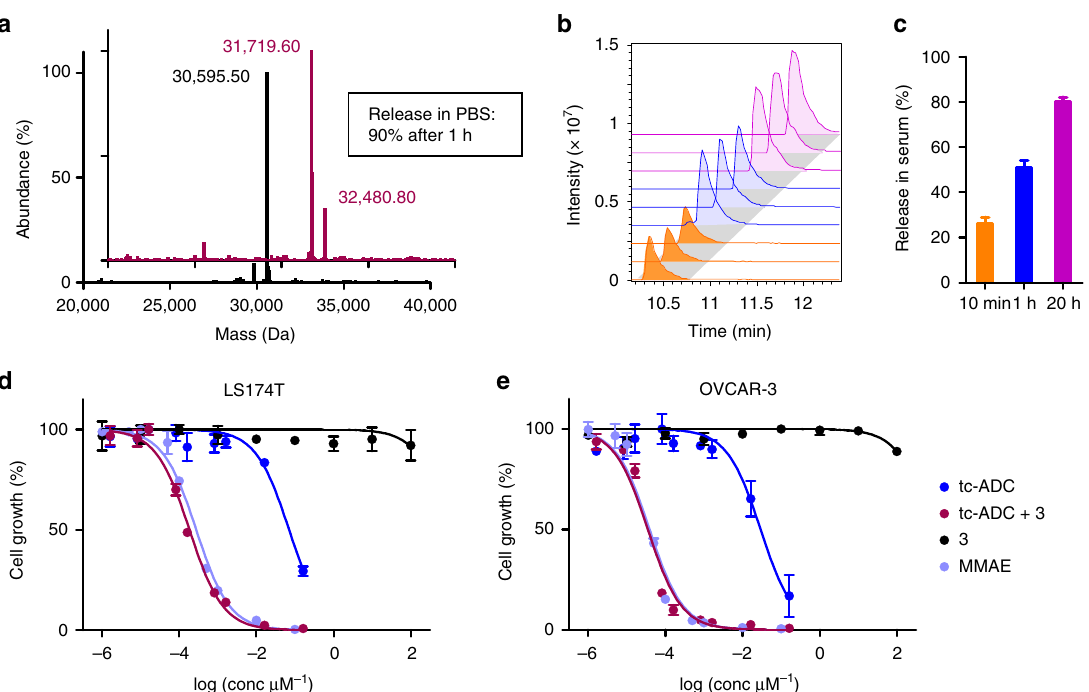
Fig. 5 Tetrazine-triggered drug release from tc-ADC in vitro. a HPLC-QTOF-MS analysis of tc-ADC showing, after deconvolution, the fully MMAE- conjugated monomer (30,595.50 Da) and, after a 1 h reaction with 3 in PBS at 37 °C, the monomer with two pyridazine derivatives and no MMAE (31719.60 Da: 80%) and the monomer with two pyridazine derivatives and one MMAE still attached (32480.80 Da; 20%). b HPLC-QTOF-MS analysis of deproteinized mixtures of tc-ADC and 3 (in triplicate) after 10 min (orange), 1 h (blue) and 20 h (magenta) incubation in 50% serum at 37 °C; c quanti fi cation of recovered MMAE using calibration curves. Cytotoxicity of combined tc-ADC and 3 in d LS174T cells (EC 50 = 185 pM) and e OVCAR-3 cells (EC 50 = 35 pM) in vitro, in comparison with only tc-ADC or 3 ; free MMAE (EC 50 = 277 and 39 pM) was used as positive control. As the ADC activation was not performed on the cell surface but in solution in the presence of the cells, similar results were obtained for the TAG72-negative HT-29 cells, see Supplementary Table 1 and Supplementary Fig.